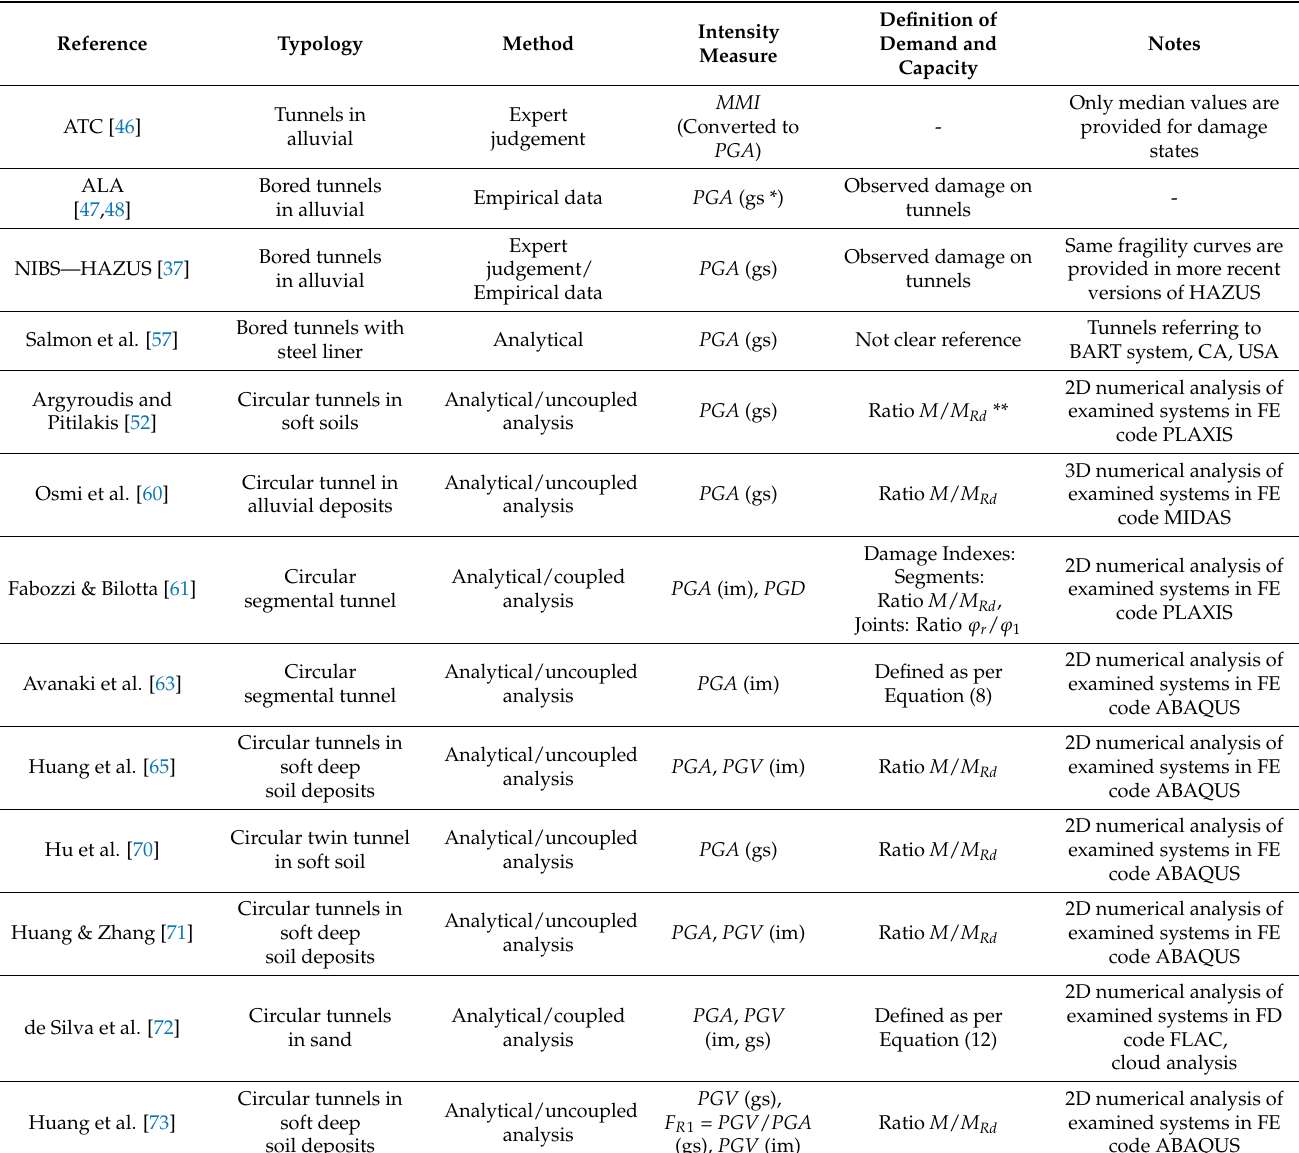
Table 3. Studies on seismic fragility assessment of segmental tunnels/bored circular tunnels in soft soils subjected to ground seismic shaking in the transversal